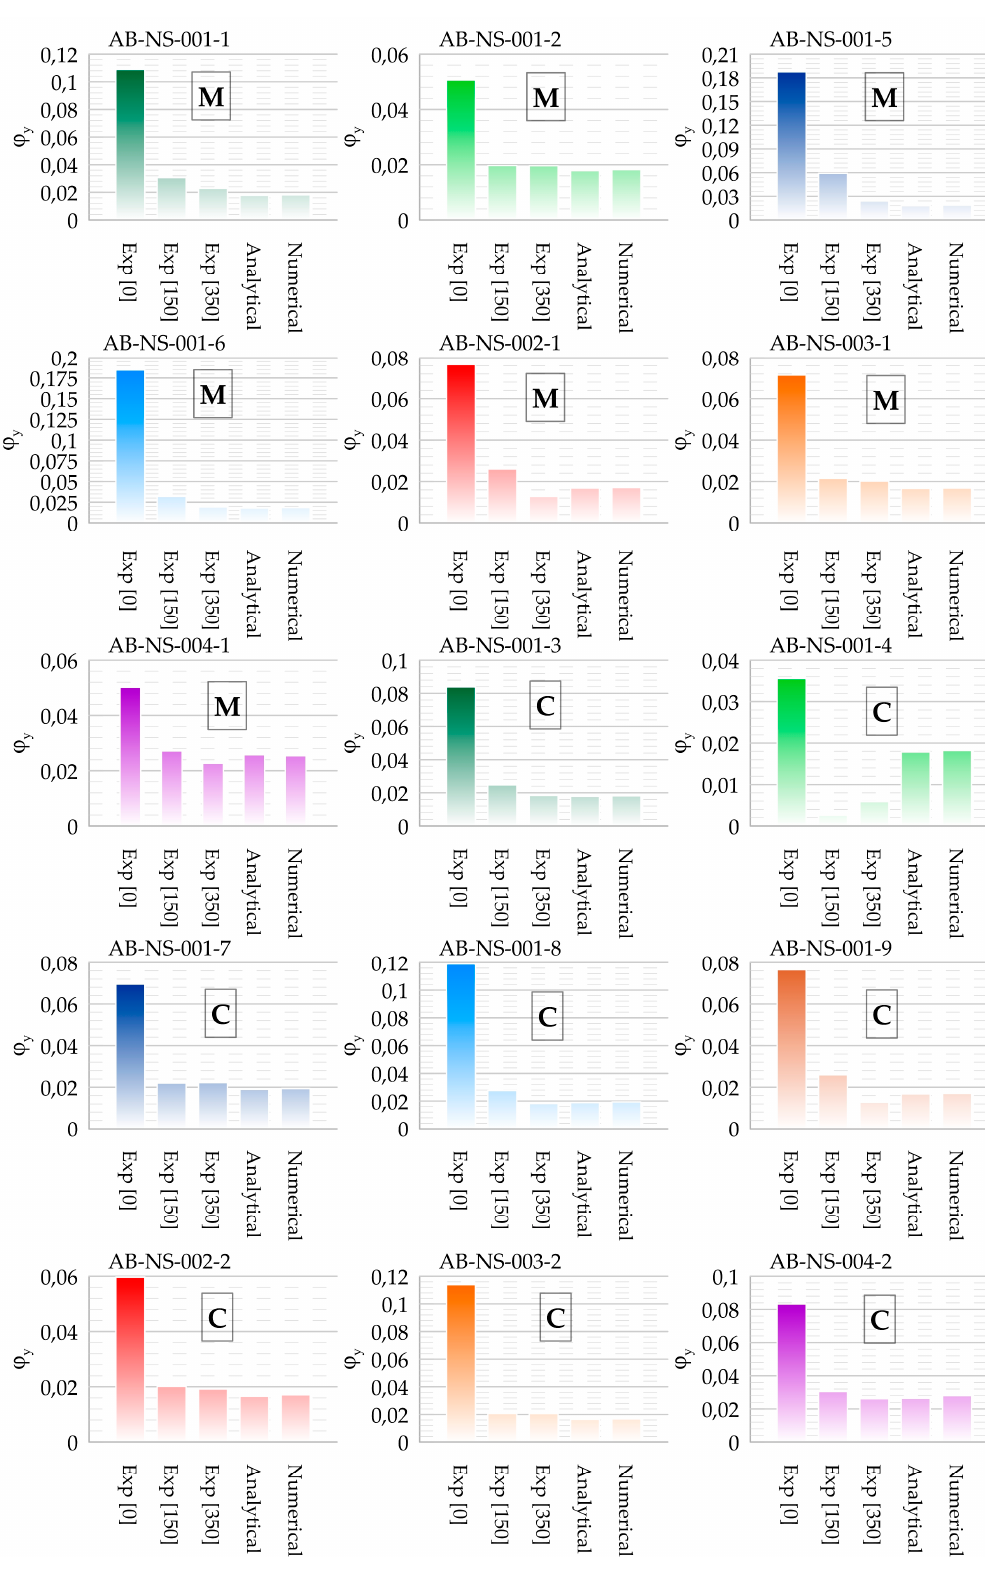
Figure 15. Section rotation when reaching yield point for monotonously (M) and cyclically (C) tested specimens.